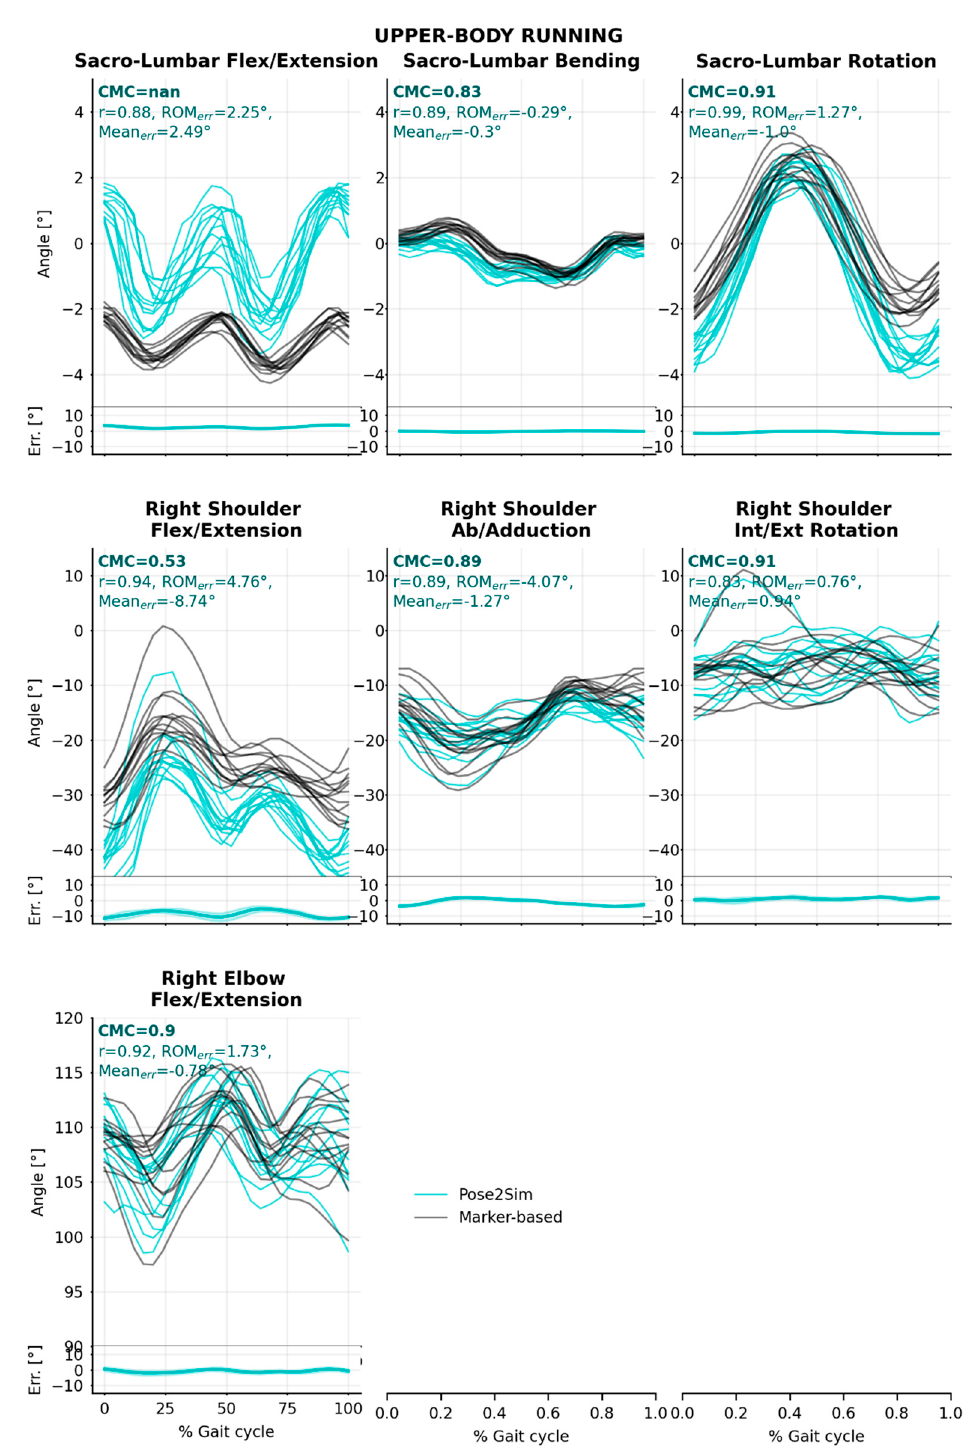
Figure A5. Pose2Sim (cyan) and marker-based (black) sacro-lumbar and upper-body joint angles for the running task. Coefficient of multiple correlation (CMC) is indicated, and broken down into, respectively, Pearson’s coefficient (r) for correlation assessment, range of motion errors (ROM err ) for gain, and overall mean error (Mean err ) for offset. Mean error and standard deviations are also represented at the bottom of the graphics.